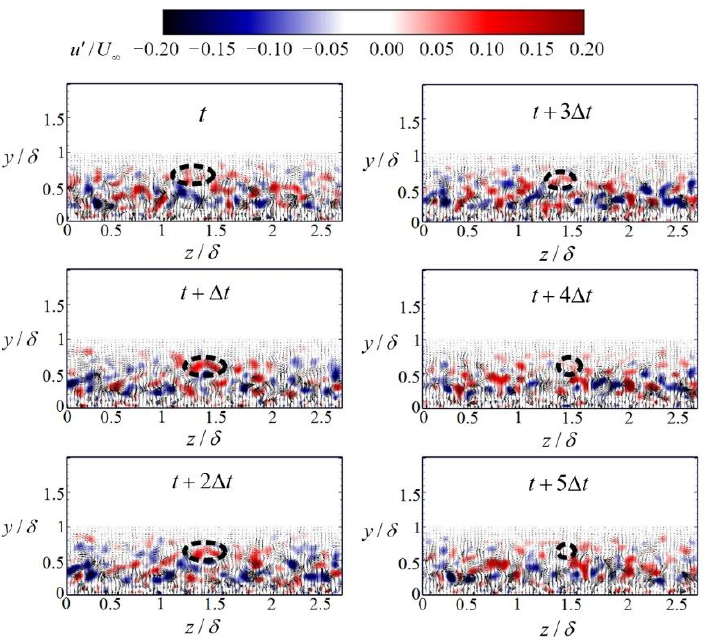
Figure 7. Streamwise pulsation velocity diagrams of the inlet turbulent boundary layer at different times.